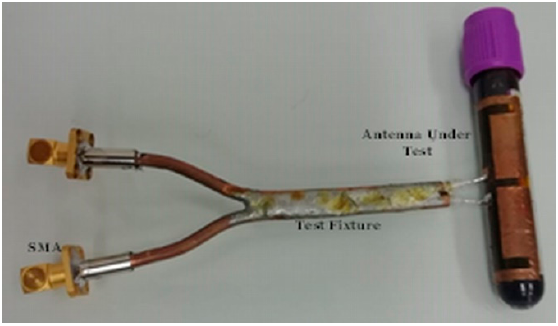
Figure 7. System for the impedance measurement of the proposed tag antenna.